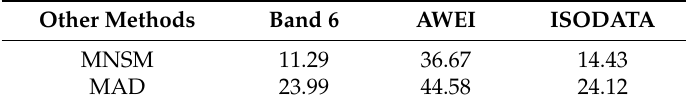
Table 4. Accuracy of three original benchmark methods in coastline extraction.